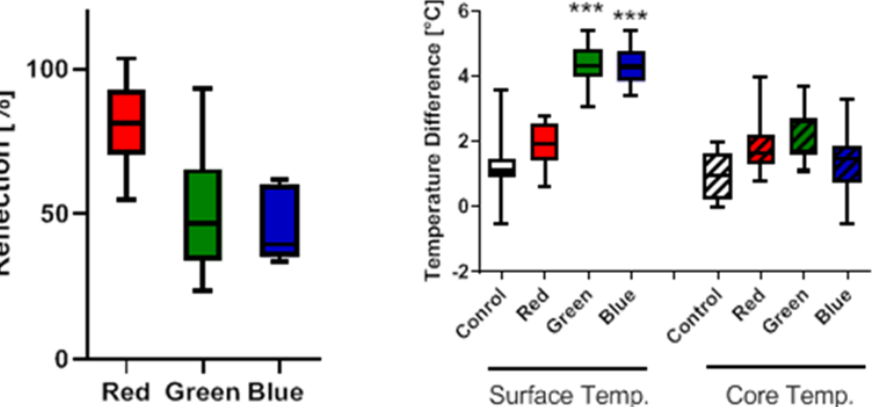
Figure 8. Physical effects of pulsing Repuls LED photobiomodulation therapy of different wave- lengths in the treated tissue. Longer wavelengths were reflected to a higher extent ( left ). This effect is associated with a limited rise in wound surface temperature in the red light group ( right ). However, as red light penetrates tissue deeper, red light induced the highest rise in the core body temperature of the animals. *** p < 0.001 compared to the control group.